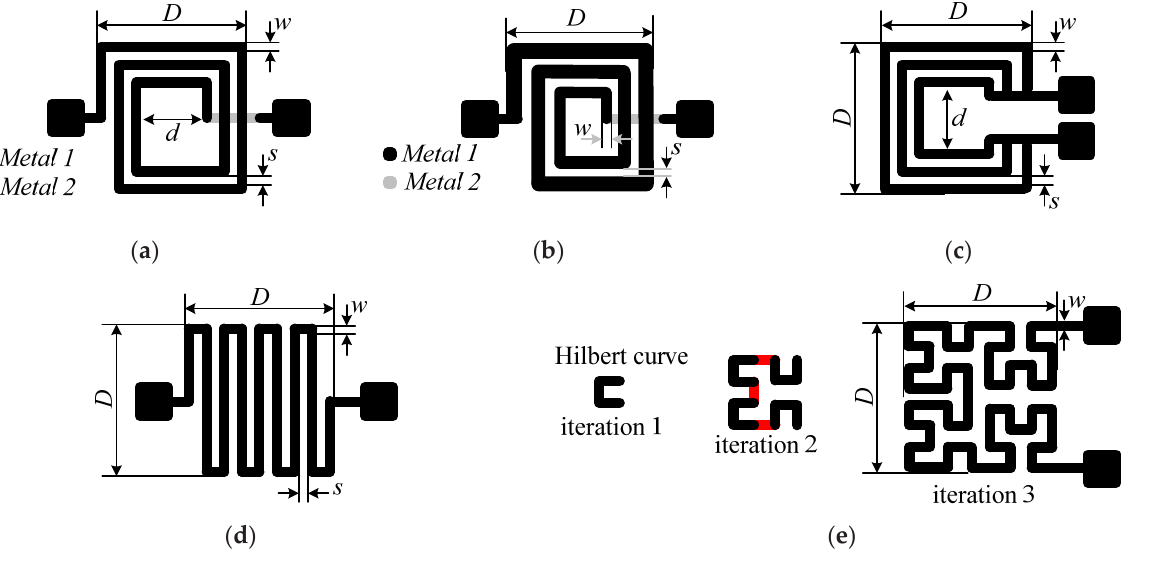
Figure 1. Evaluated square planar topologies: ( a ) spiral, ( b ) tapered, ( c ) non-spiral, ( d ) meander, and ( e ) fractal (based on Hilbert curve: iteration 1, iteration 2–connections are in red–, and iteration 3).